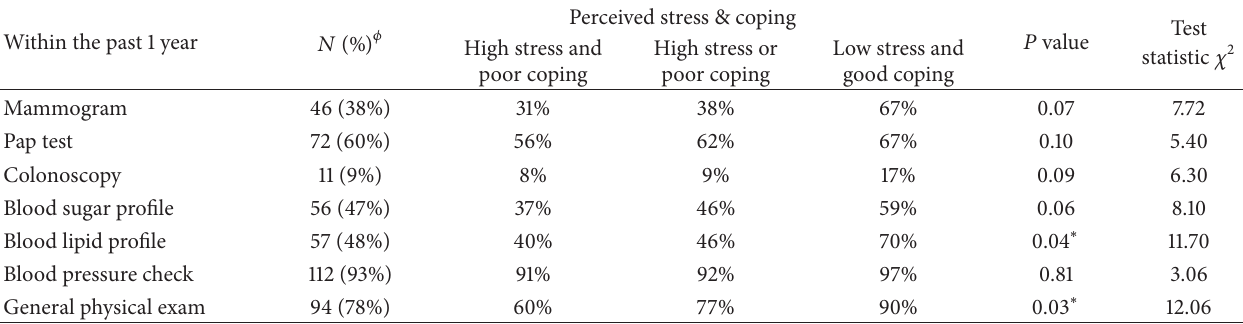
Table 6: Preventive health and screening behaviors in the past year comparison by stress and coping. Within the past 1